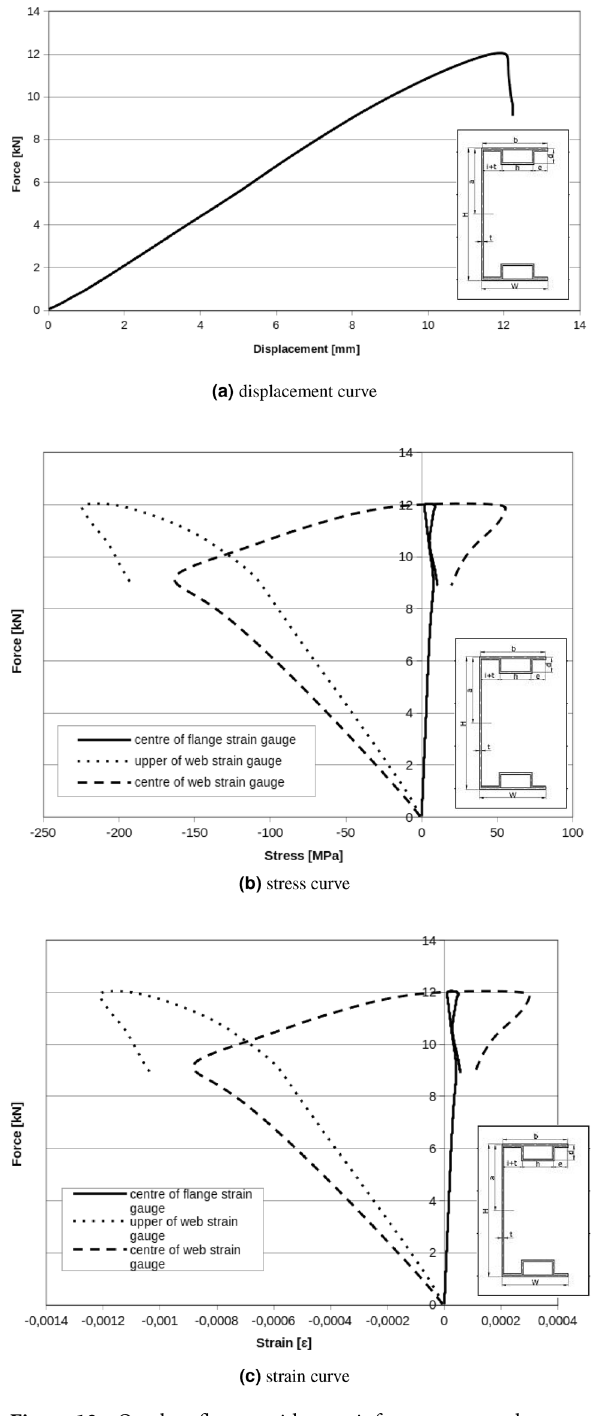
Figure 13. One box flanges without reinforcement